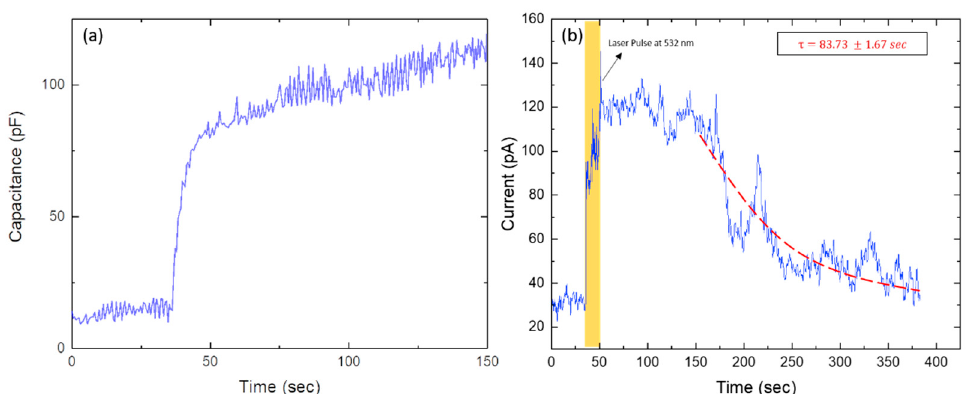
Figure 2. ( a ) Electrical capacitance as measured between the two microfluidic channels, separated by an oil phase (see Figure 1a) as a function of time. The signature of bilayer formation is the sudden increase in capacitance. ( b ) A real-time current recording of the bilayer containing Arch-3-EGFP. In the absence of light, we observe a current signal fluctuating around a constant value. The sudden jump in the current signal demonstrates the activation of Arch-3 caused by a green laser pulse applied to the bilayer at ~40 s ≤ t ≤ 50 s. The signal decays, with a time constant of ~84 s, to its initial dark value. The recovery time corresponds to the re-protonation of the Schiff base as reported in [38–40].